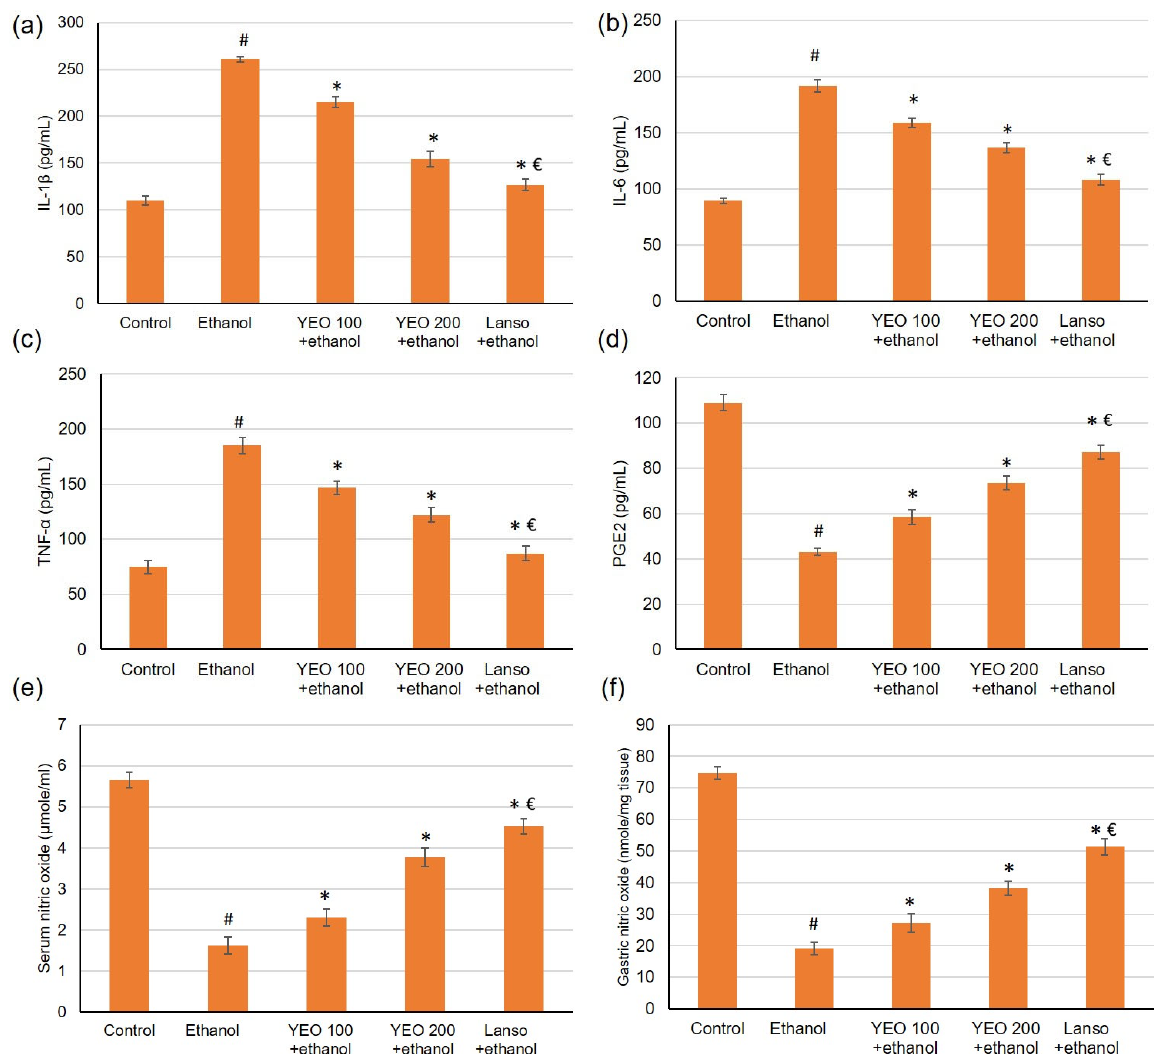
Figure 4. Effects of YEO (100 and 200 mg/kg) administration in acute gastric injuries induced by ethanol on serum inflammatory cytokines markers including ( a ) IL-1 β , ( b ) IL-6, and ( c ) TNF- α and on gastric mucosa defensive factors including ( d ) PEG2, ( e ) serum NO, and ( f ) gastric NO. All data are quantified as mean ± SE, ( n = 6 ). (#) defines statistically significant related to the control, (*) signifies statistically significant related to the ethanol-induced gastric mucosal injuries, and ( € ) designates statistically significant related to YEO 200 + ethanol via one-way ANOVA after Tukey’s post hoc test ( p < 0.05).